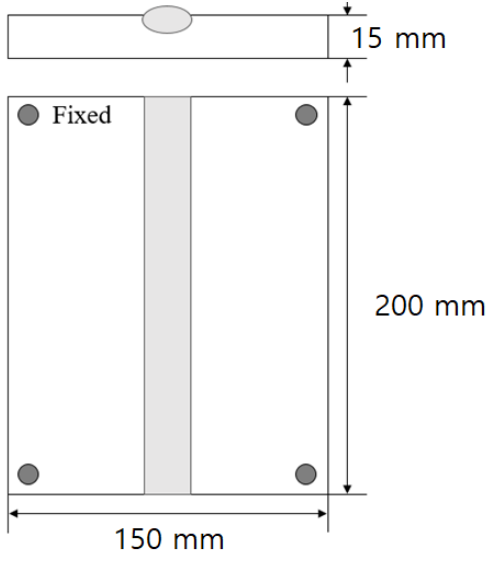
Figure 1. Welding specimen and constraint a schematic diagram.